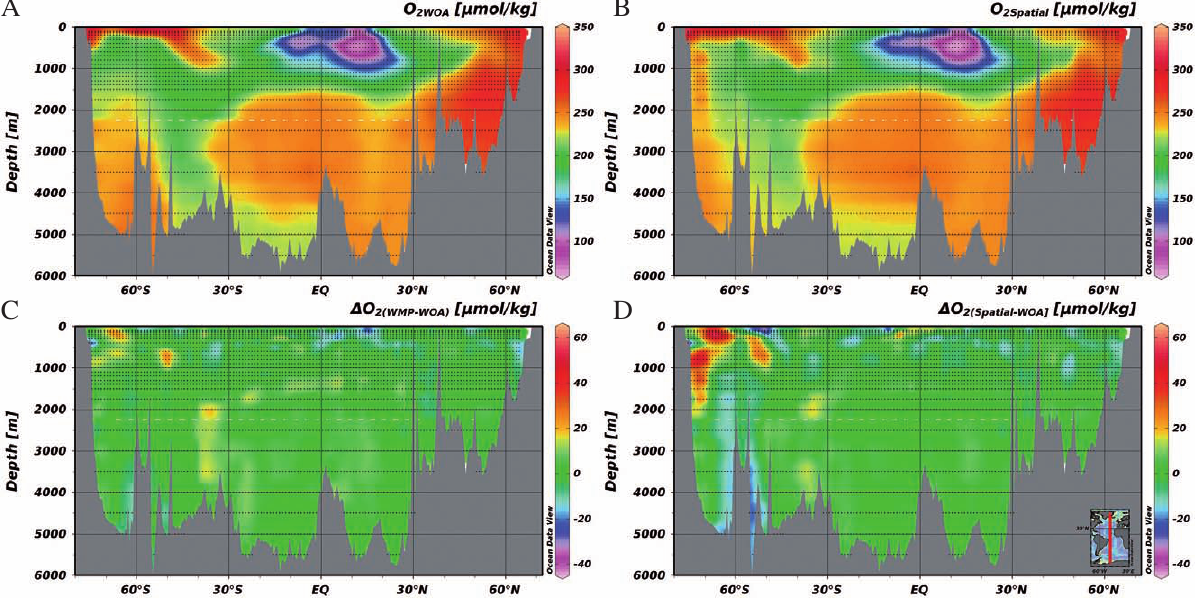
(µmol kg -1 ) variability along 28ºW from the WOA05 dataset (A), spatially interpolated from CARINA data (B). Residuals of Fig . 5. – O 2 WMP interpolated (C) and spatially interpolated (D) O